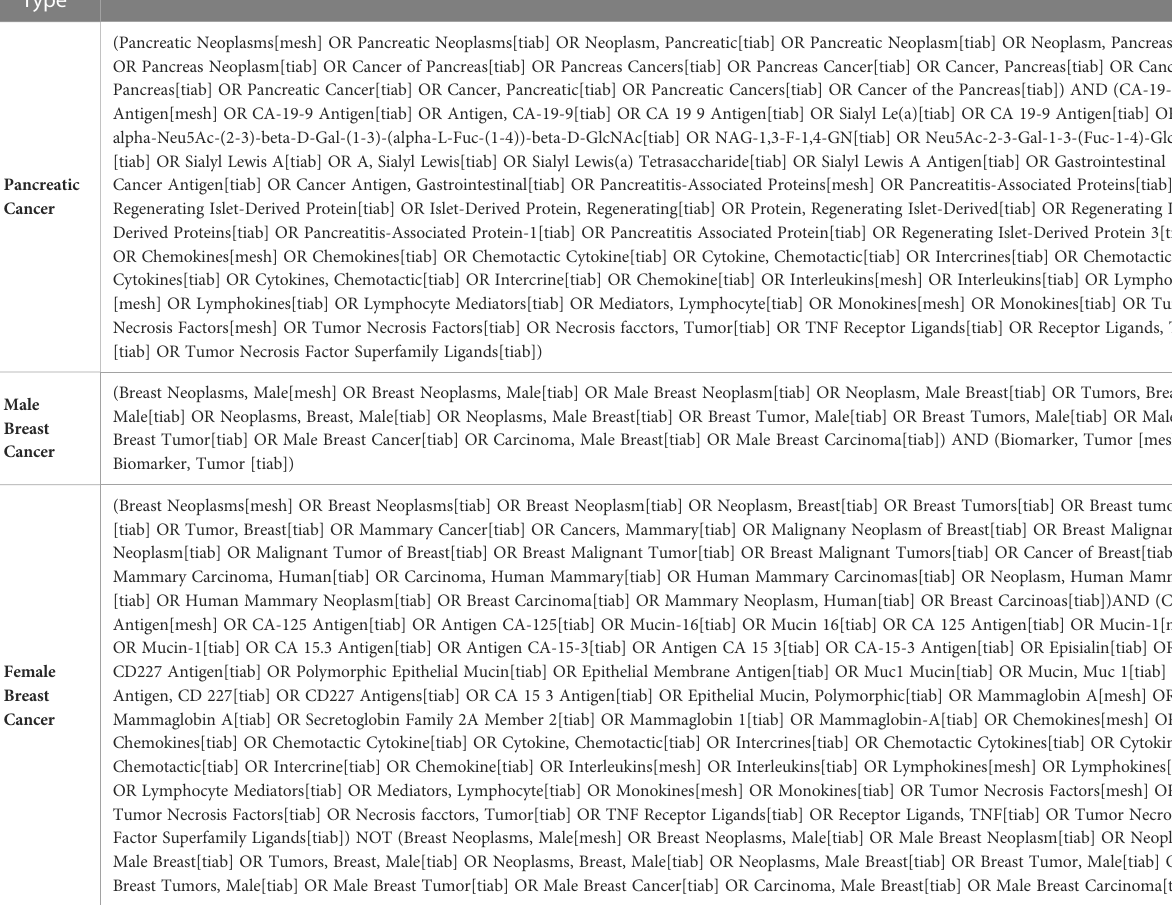
TABLE 1 Complete list of search terms for Reviewed Cancer Types from PubMed mesh term search. Cancer